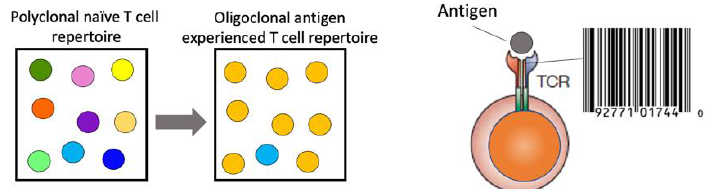
Figure 1. Clonal outgrowth of a T cell with a unique TCR (barcode) due to stimulation with its cognate antigen that generates shifts in the composition of TCR repertoire.